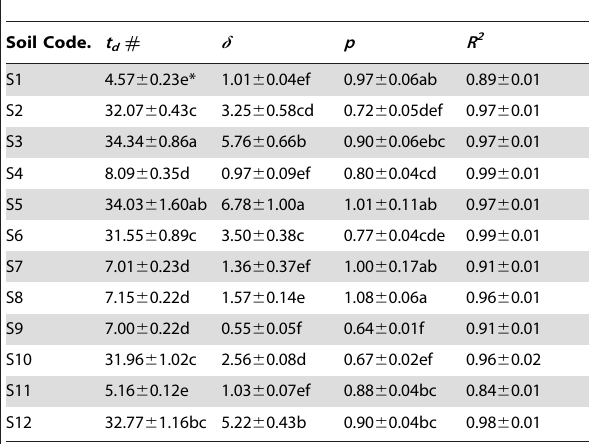
Table 2. Statistical measures and fitted parameter values of the Weibull model describing the survival of E . coli O157:H7 in soils.